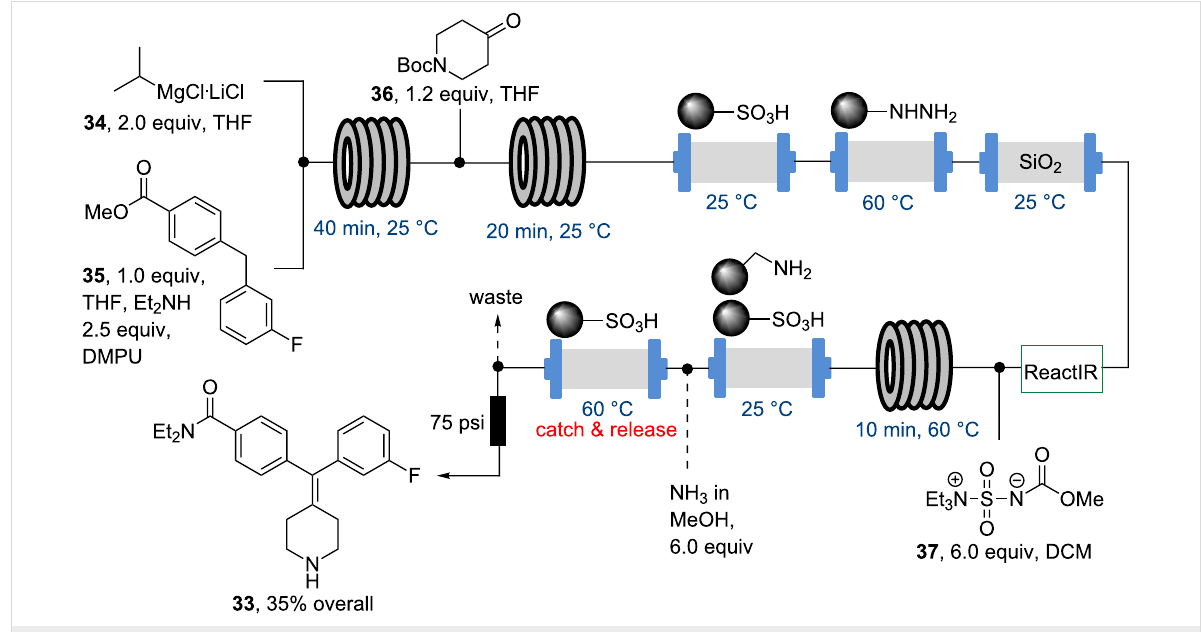
Scheme 6: Flow synthesis of a selective δ -opioid receptor agonist 33